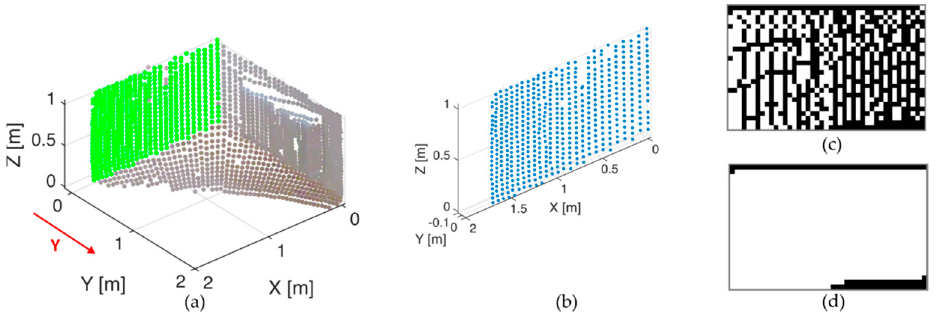
Figure 10. Planar surface detection in X-axis: ( a ) 2nd level selection in the X-axis; ( b ) Segmented point cloud; ( c ) Resulting level image; ( d ) Morphologically closed and opened image.